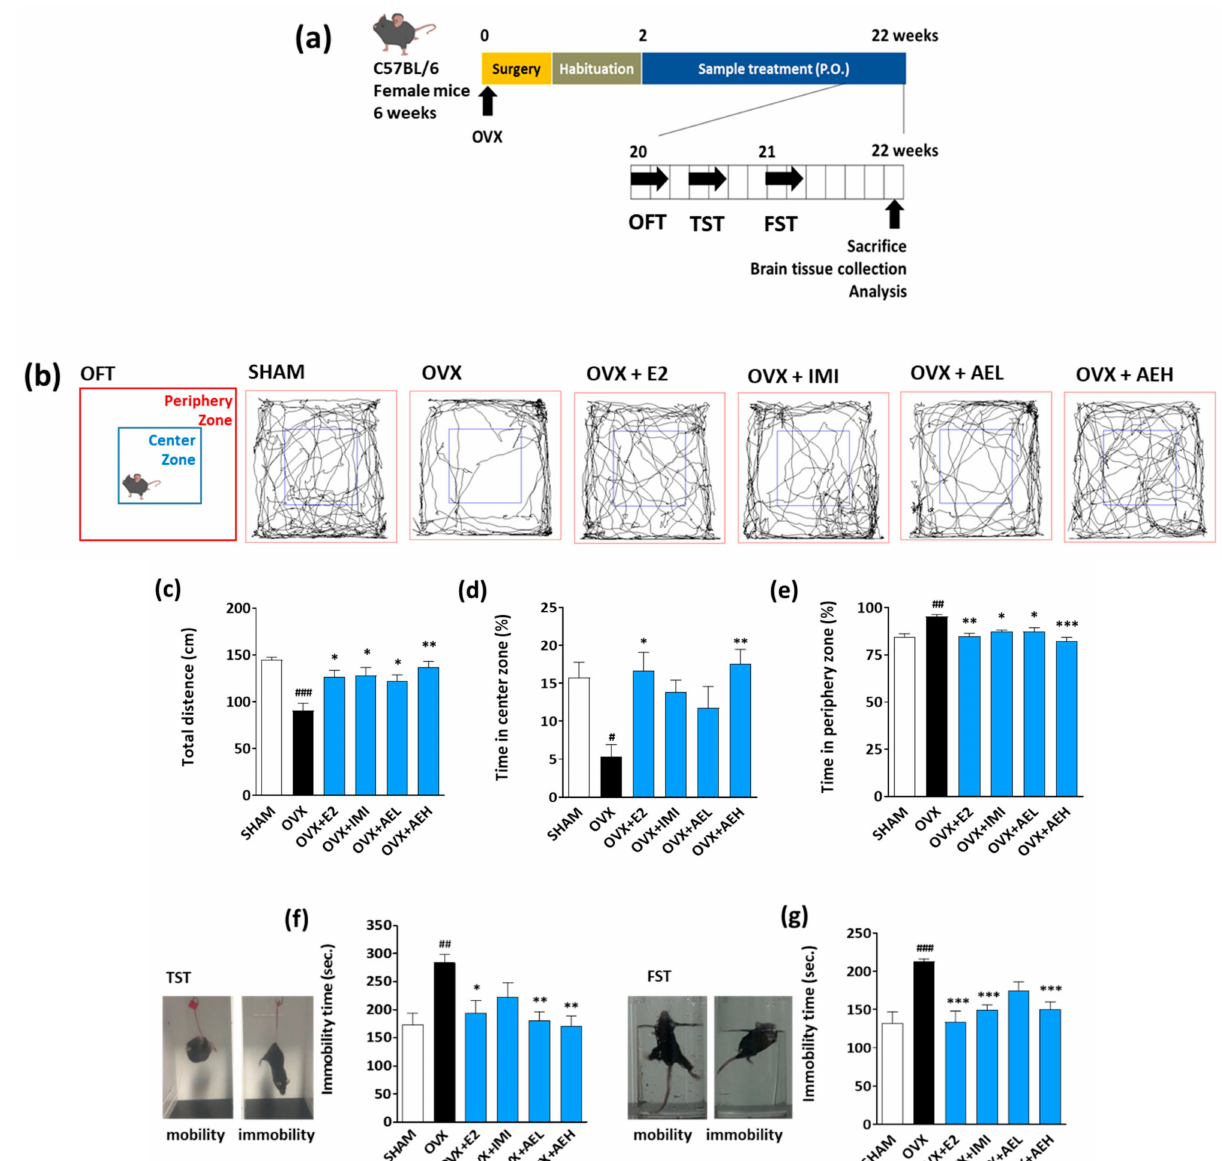
Figure 2. AE improves depressive-like behavior in OVX mice. ( a ) Experimental design and treatment schedule. OVX mice were orally administered AE (100 and 300 mg/kg, p.o.) for 20 weeks. ( b ) The tracing of the locomotor activity for 5 min. OVX mice exhibited depressive-like behavior, while AE led to significantly improved behaviors; ( c ) total distance, ( d ) time in center zone, and ( e ) time in periphery zone. OVX mice exhibited significantly increased immobility, while AE-treated mice showed significant improvements, with a reduced immobility time in the ( f ) TST and ( g ) FST. Results are presented as mean ± SD. OFT, open filed test; TST, tail suspension test; FST, forced swim test; E2, 17 β -estradiol 10 µ g/kg; IMI, imipramine 30 mg/kg; AEL, AE 100 mg/kg; AEH, AE 300 mg/kg. # p < 0.05, ## p < 0.01, and ### p < 0.001 vs. SHAM group; * p < 0.05, ** p < 0.01, *** p < 0.001 vs. OVX